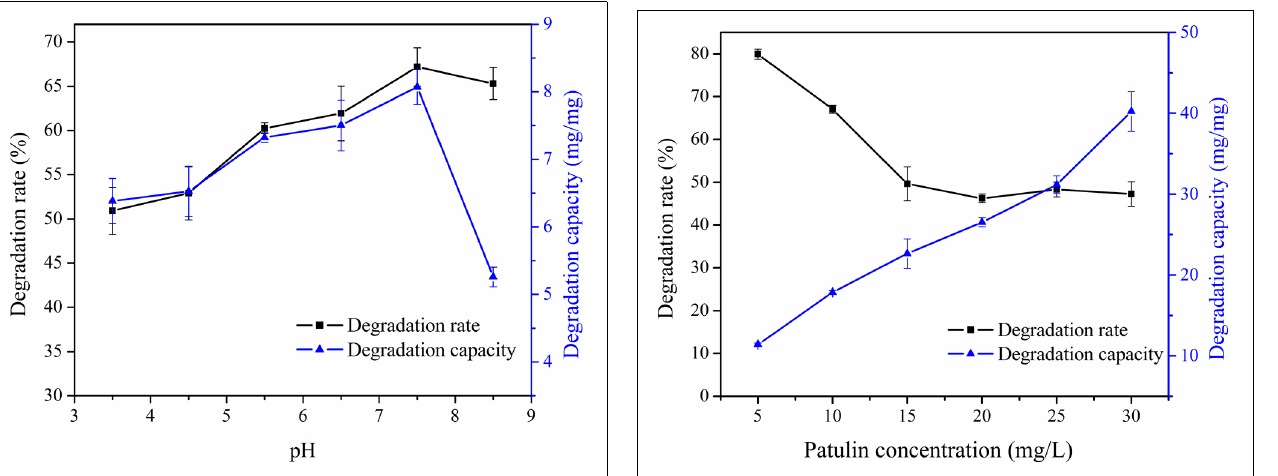
FIGURE 5 | Effect of initial concentration on degradation rate and degradation capacity of PPL for